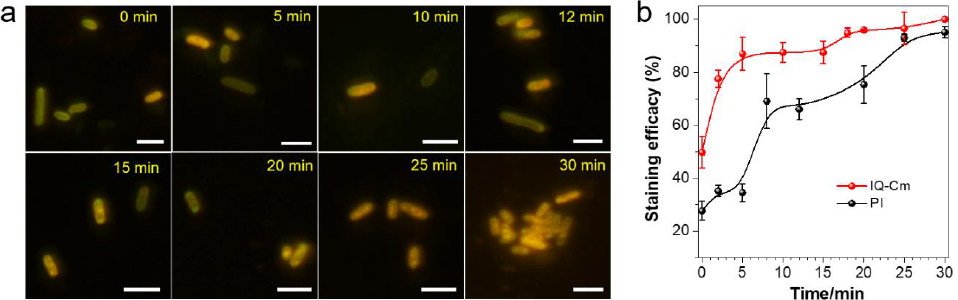
Figure 4. Visualization of the antimicrobial effect of antimicrobials with different incubation times. ( a ) Fluorescence images of E. coli treated with 20 µ M of CTAB for different times and then stained with IQ-Cm (10 µ M) for 10 min. Scale bar: 2 µ m. ( b ) The staining efficacy of IQ-Cm and PI for E. coli versus the incubation time of E. coli with CTAB.